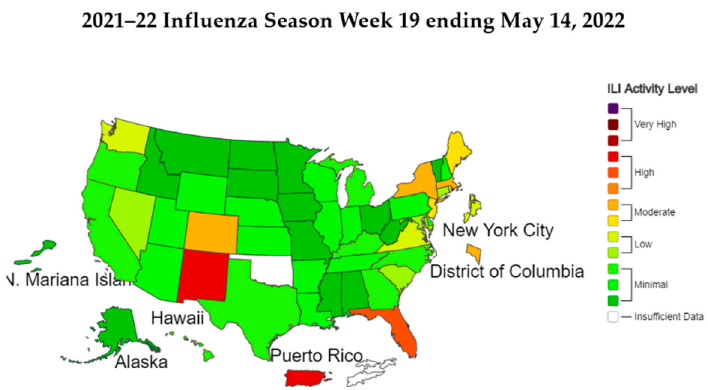
Figure 6. Influenza activity according to the CDC.